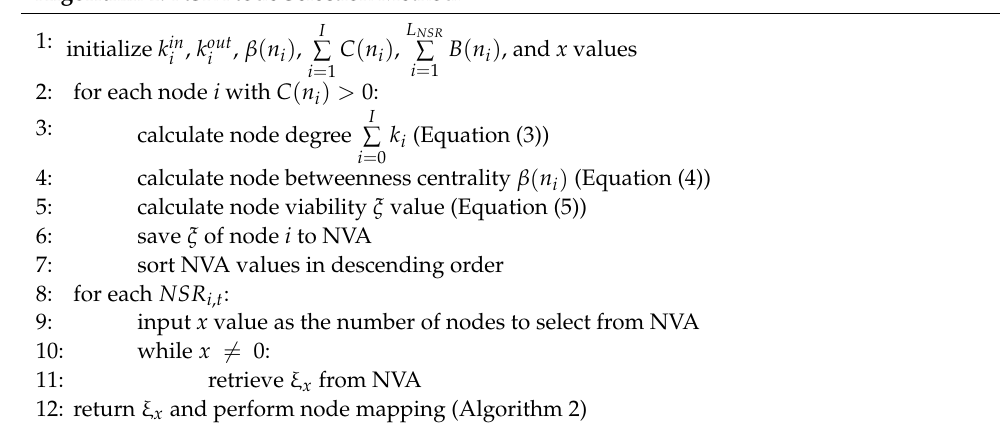
Algorithm 1. NSR Node Selection